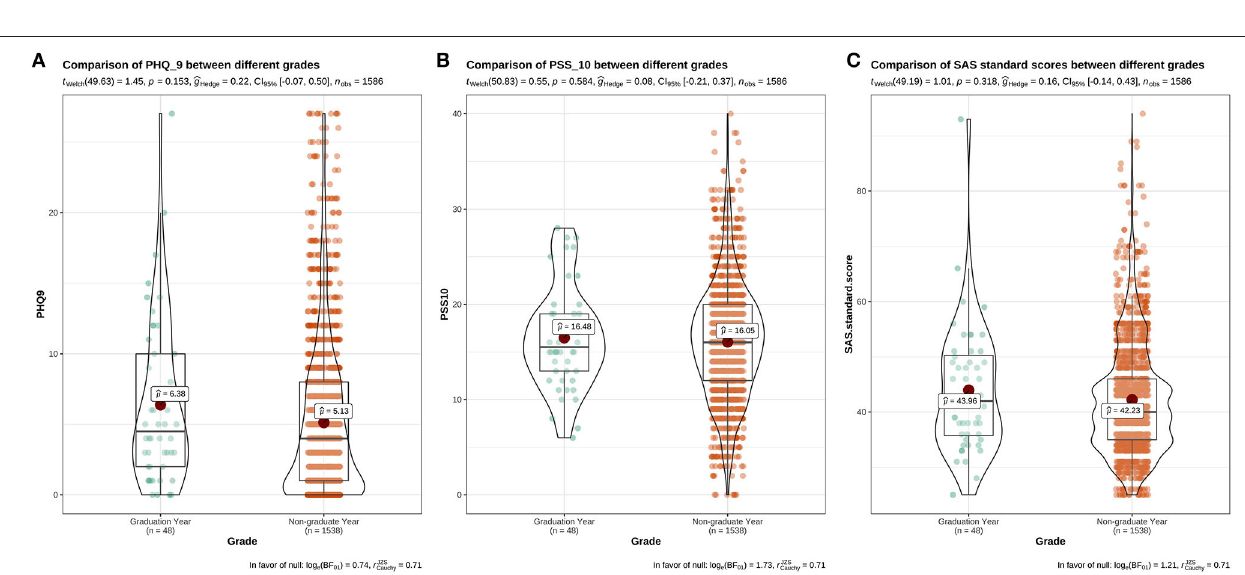
FIGURE 3 | The distribution maps of PHQ-9, PSS-10, and SAS scores in different grades. (A) Distribution of PHQ-9 scores in different grades; (B) Distribution of PSS-10 scores in different grades; (C) Distribution of SAS scores in different grades.